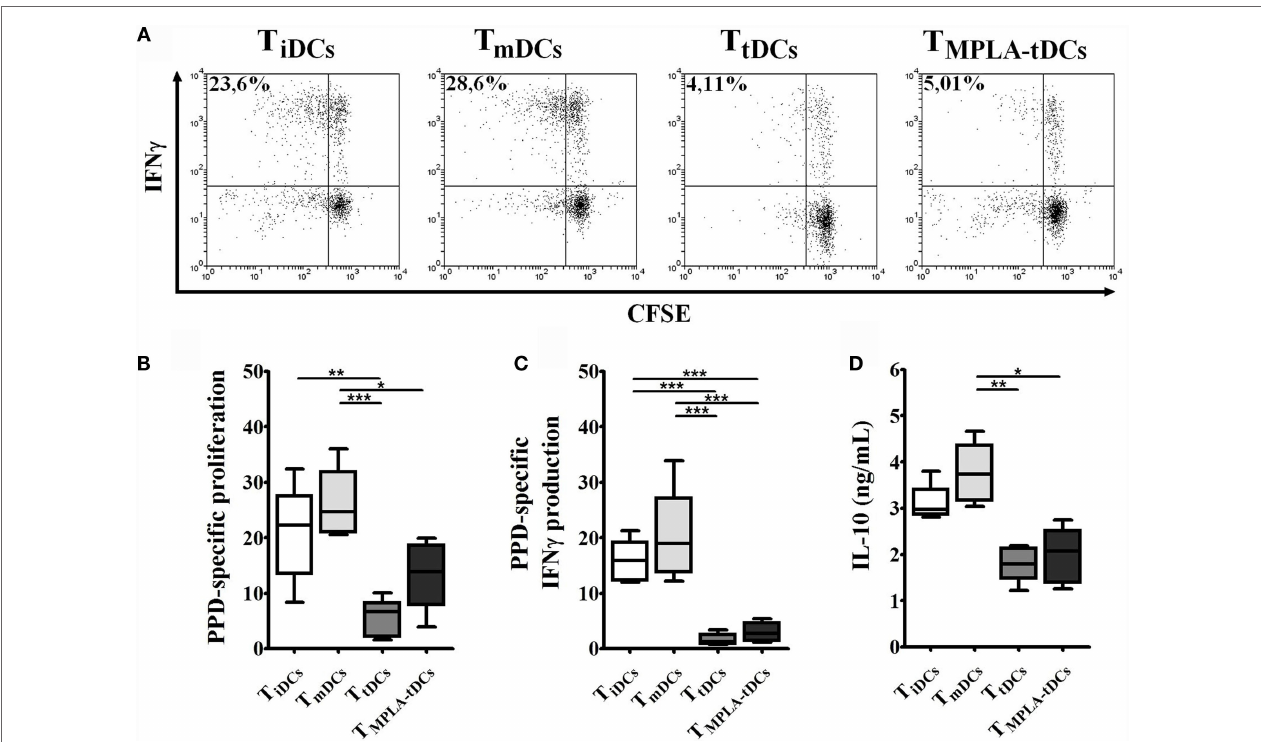
FigUre 3 | MPla-tDcs render memory cD4 + T cells to be hyporesponsive to restimulation . For restimulation assays, memory CD4 + T cells were primed with PPD-loaded DC subsets and then were recovered, washed, labeled with CFSE, and restimulated with unpulsed or PPD-pulsed mDCs. Data were normalized by subtracting values of unpulsed conditions to antigen-specific conditions. (a) Representative dot plots of IFN- γ expression from six independent experiments are shown. (B) Proliferation of restimulated primed-CD4 + T cells was determined by CFSE dilution through flow cytometry and graphic representation of normalized data of the percentage of CFSE low in CD4 + T cells is shown. (c) IFN- γ expression was detected intracellularly and analyzed by flow cytometry. Graphic representation of normalized data of the percentage of IFN- γ producing proliferating CD4 + T cells (CFSE low ) is shown. (D) IL-10 secretion levels from mDC/primed-T cell co-culture supernatants were measured using ELISA. For (B–D) , statistical differences were calculated using Friedman test (for non-parametric data) or one-way ANOVA (for normally distributed data) followed by Duns or Tukey post-test, respectively (* P < 0.05; ** P < 0.01; *** P <